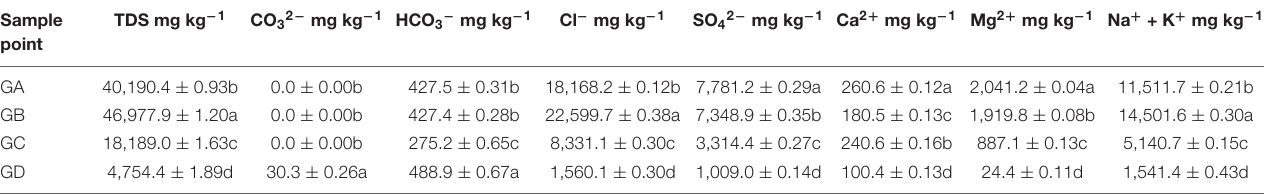
Data are means ± standard deviation (n = 3). Values in the same column followed by the same letter(s) are not significantly different at p < 0.05. Salicornia europaea rhizosphere soils (GA), Suaeda salsa rhizosphere soils (GB), Phragmites communis rhizosphere soils (GC), and Achnatherum splendens rhizosphere soils (GD).